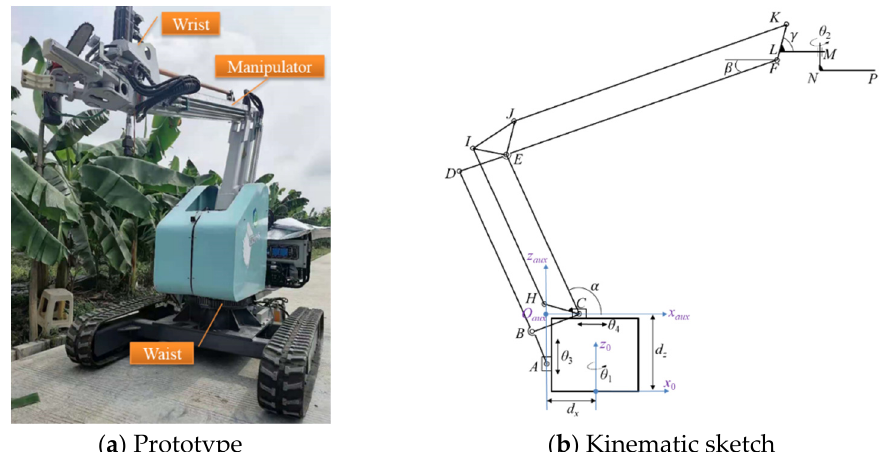
Figure 2. Series ‐ parallel hybrid banana ‐ harvesting robot.